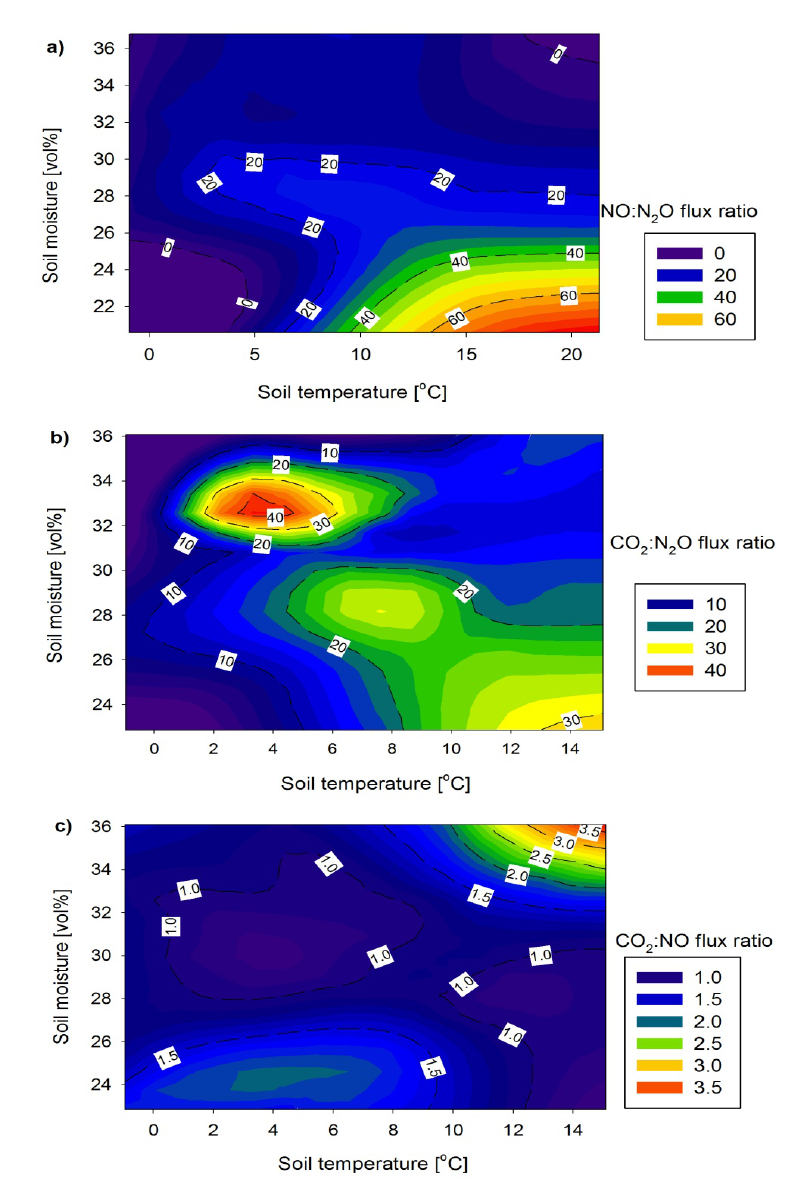
Fig. 8. Conjunct effects of soil moisture (in 10cm soil depth) and temperature (in 5cm soil depth) on monthly flux ratios of (a) NO:N 2 O; (b) CO 2 :N 2 O; (c) CO 2 :NO. Note that CO 2 fluxes were divided by 1000 for this analysis. Prior to the calculation of contour lines, data were smoothed with the Loess algorithm (sampling proportion = 1).